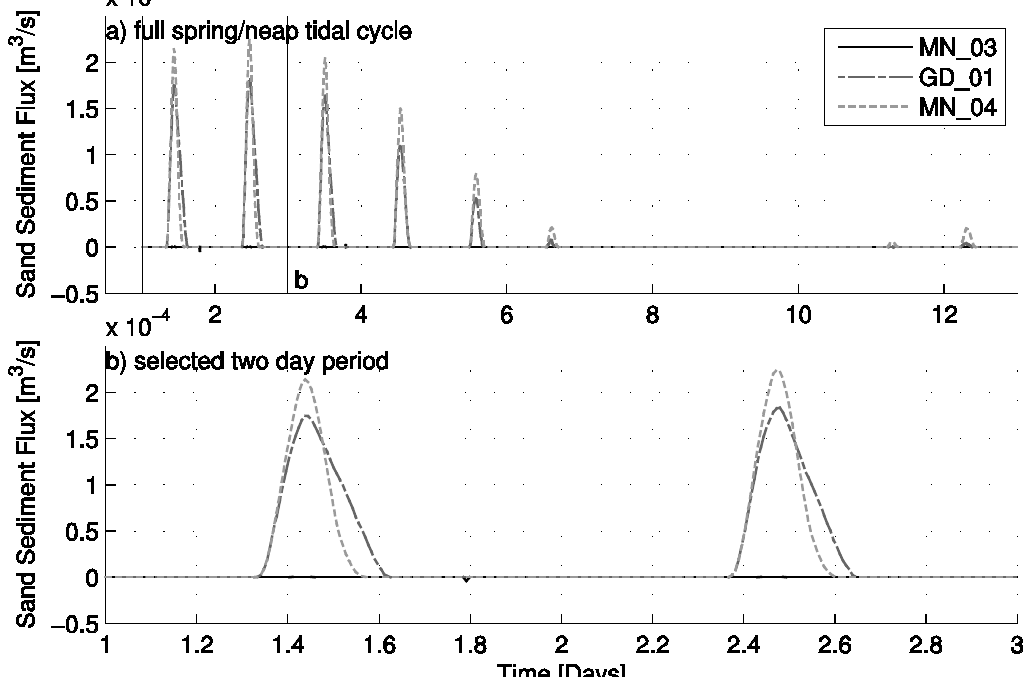
Fig. 3 Sand-fraction sediment flux through transects upstream (MN_03) and downstream (GD_01 and MN_04) of a bifurcation in Wax Lake Delta distributary channels (see Fig. 1 for locations): (a) gives the flux variation over the full simulation period of a spring/neap tidal cycle; (b) zooms in on a two day spring tide period marked with the box in part